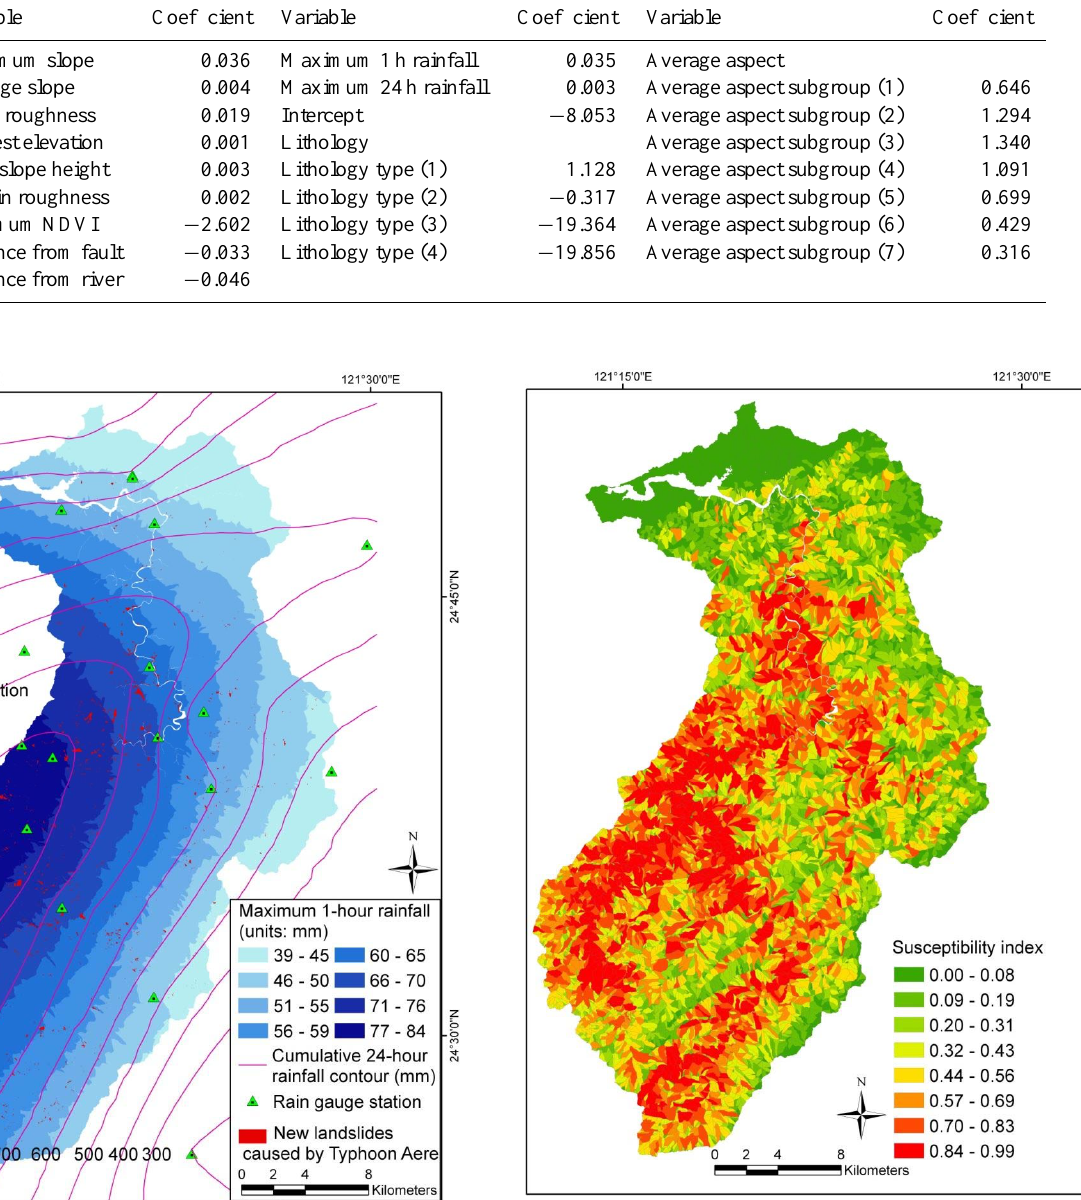
Fig. 5. Landslide susceptibility map based on logistic regression model using rainfall of Typhoon Aere as triggering Typhoon Aere as triggering factors. 4